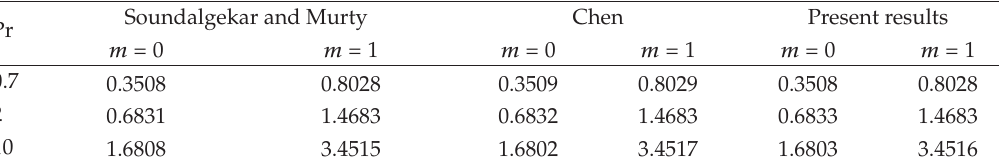
Table 2: Numerical comparison of Nu x Re − 1 / 2 x for ψ (cid:8) 0 to previously published